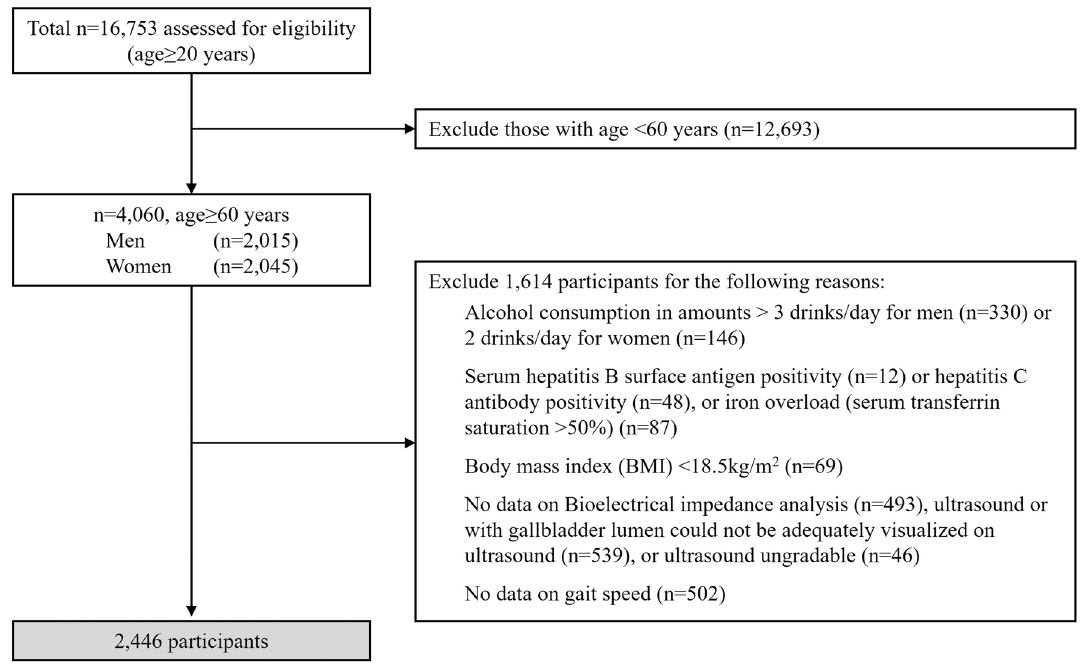
Figure 1. Flow diagram of subject inclusion and exclusion in the NHANES